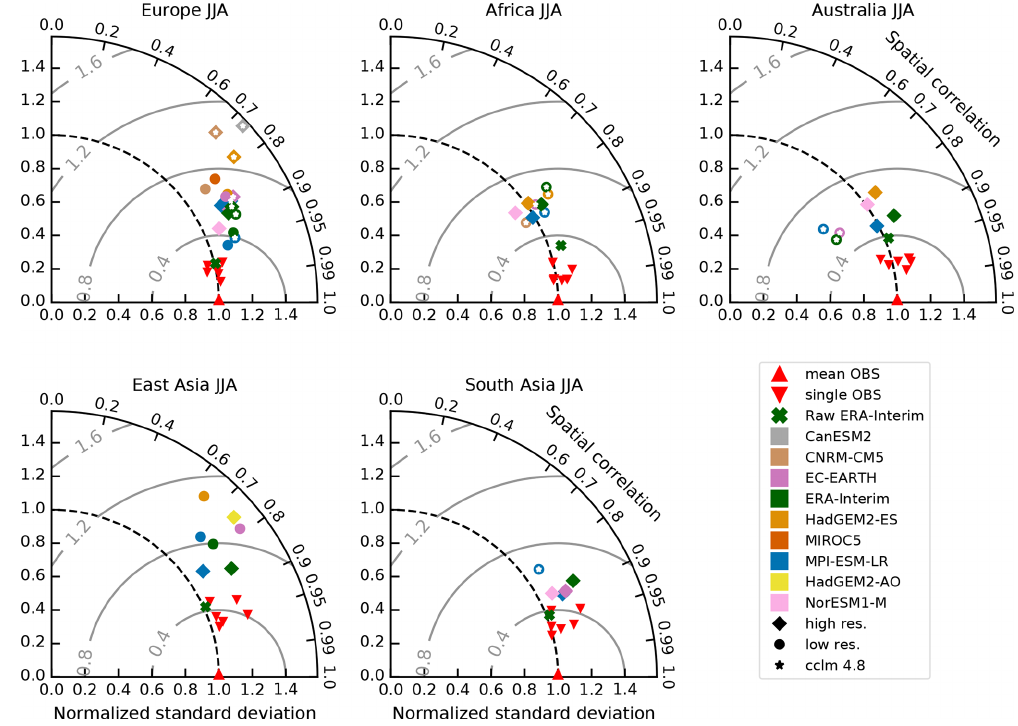
Figure 8. Same as Fig. 7 but for JJA, without the zoomed